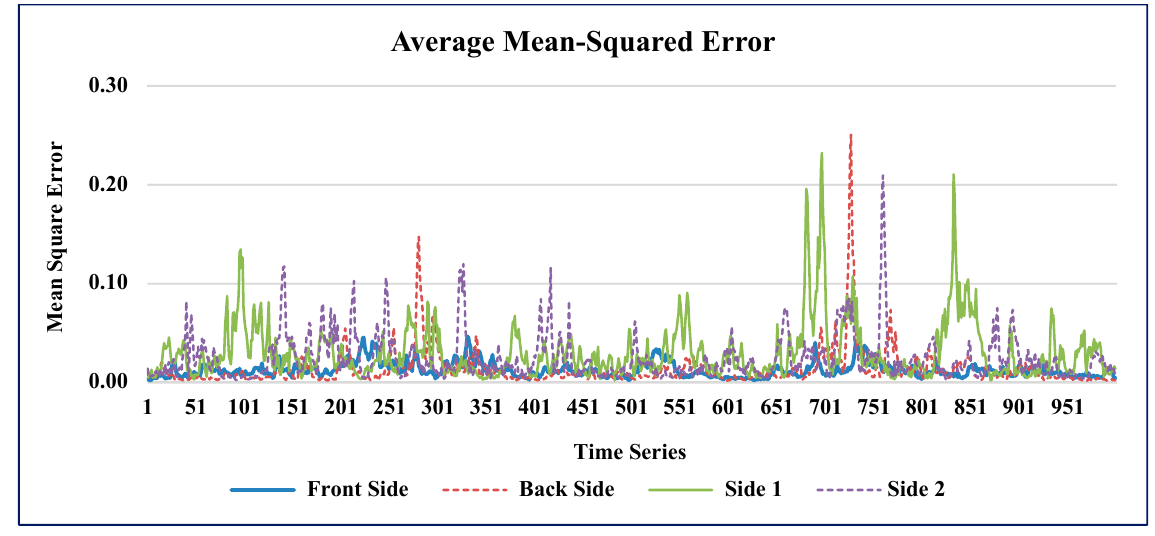
Figure 10. AMSE predicted by GAIN.